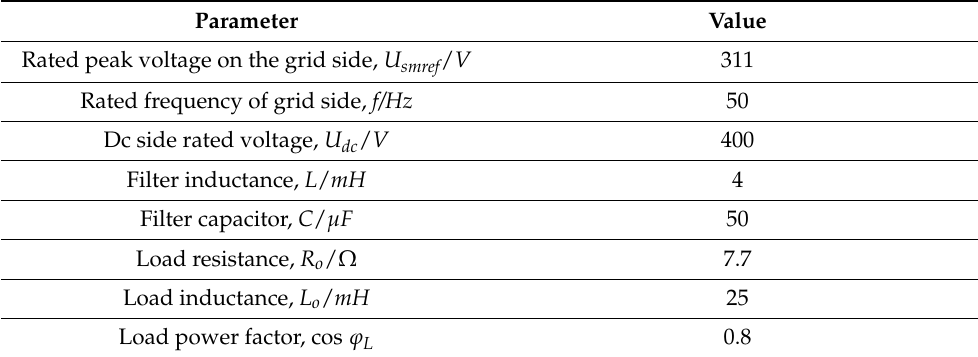
Table 1. Simulation parameters of